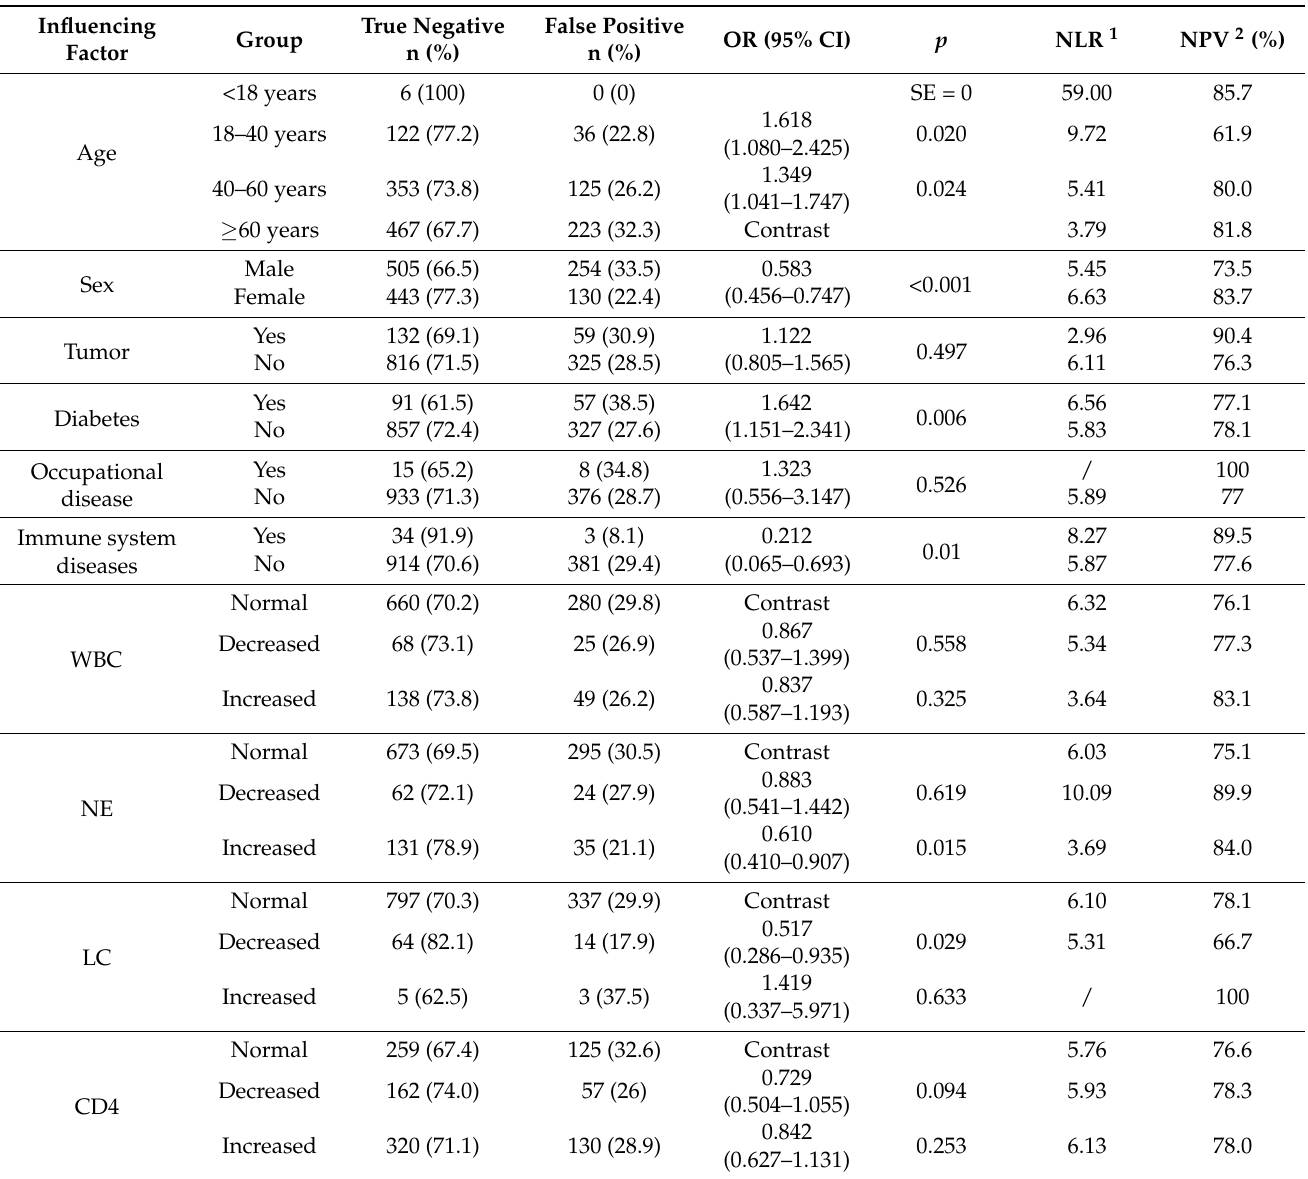
Table 4. Single-factor risk analysis of false-positive and true-negative QFT-GIT results in the diagnosis of active